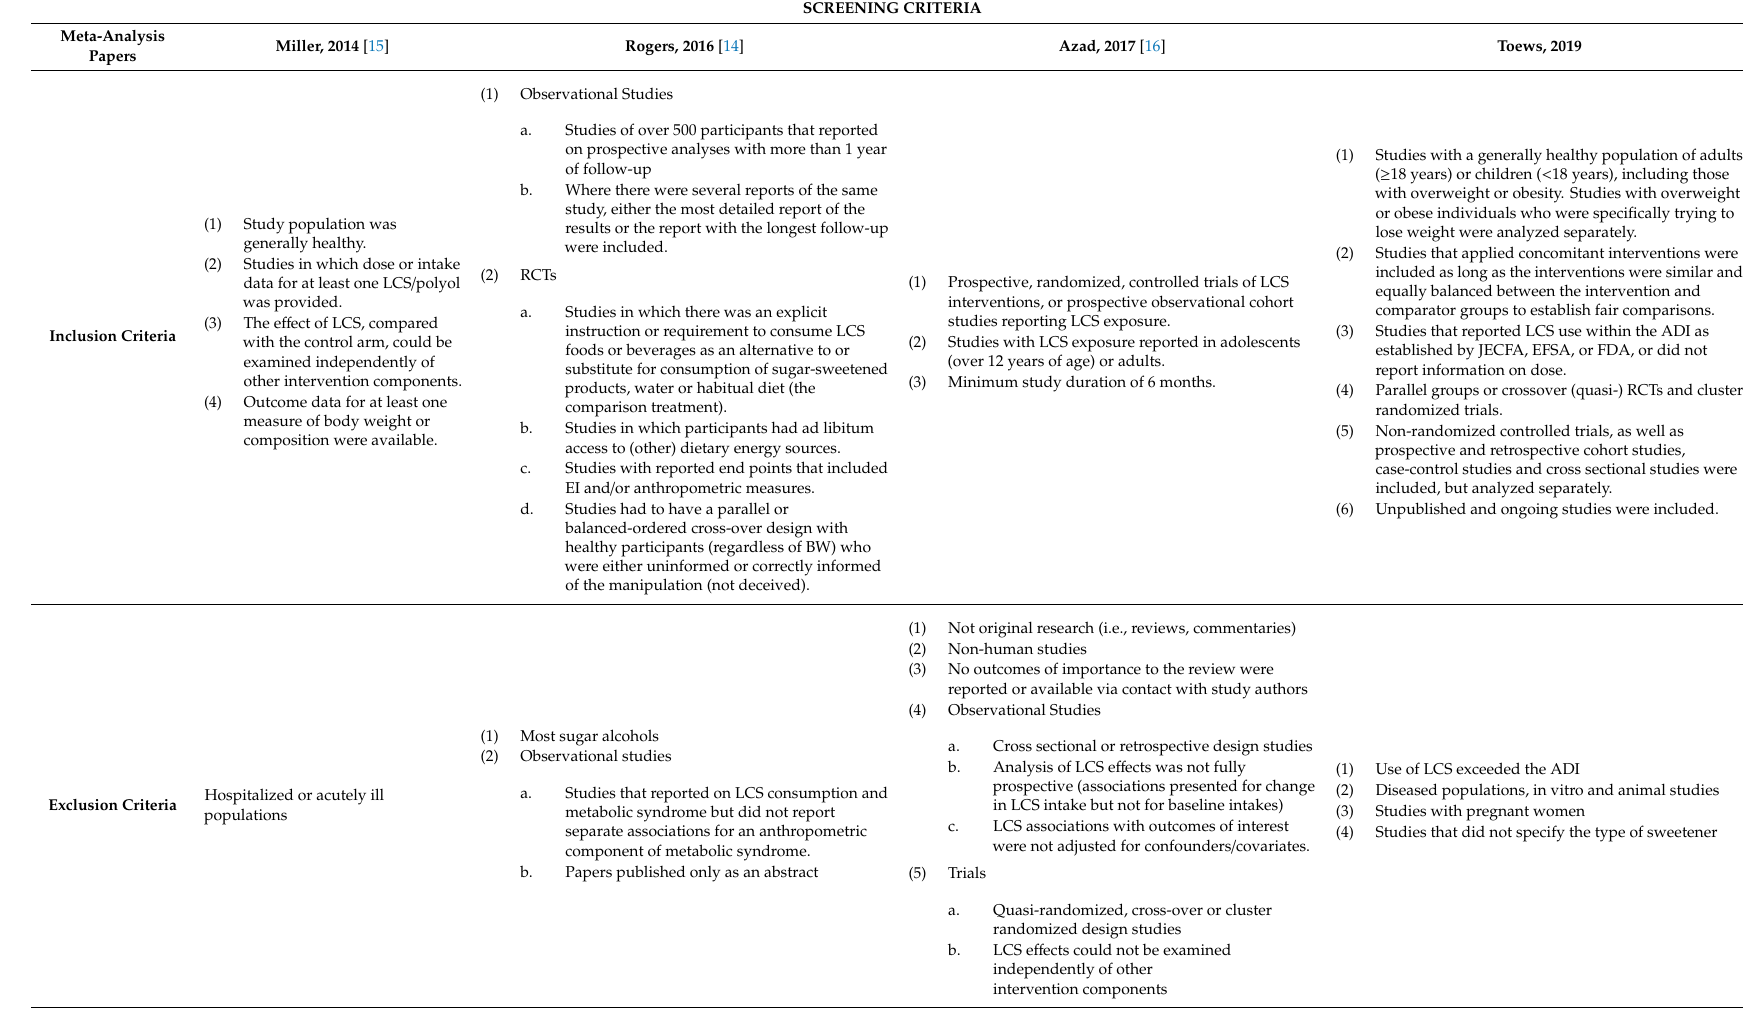
Table 1. Screening criteria for recent meta-analyses (I = included